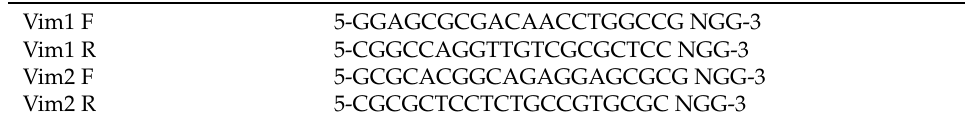
Table 1. The designed sgRNA oligonucleotide